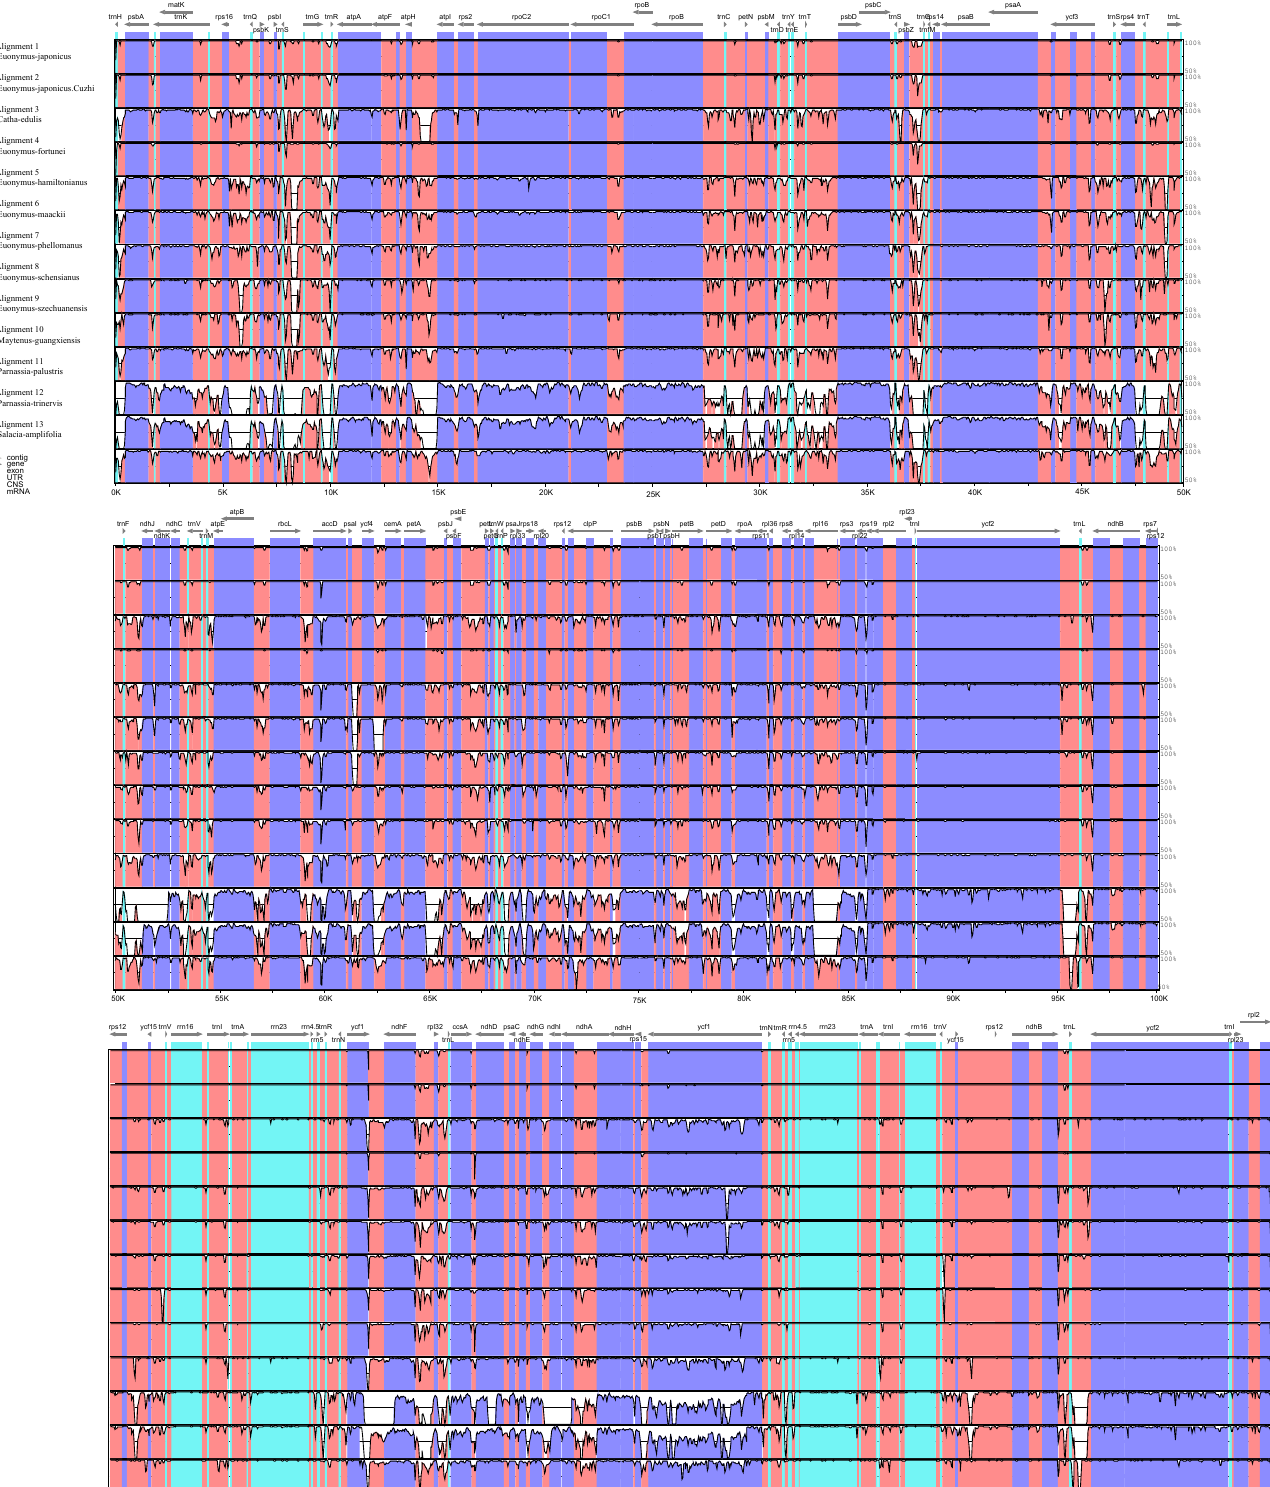
Figure 11. Comparison of chloroplast genome sequences among 13 Celastraceae